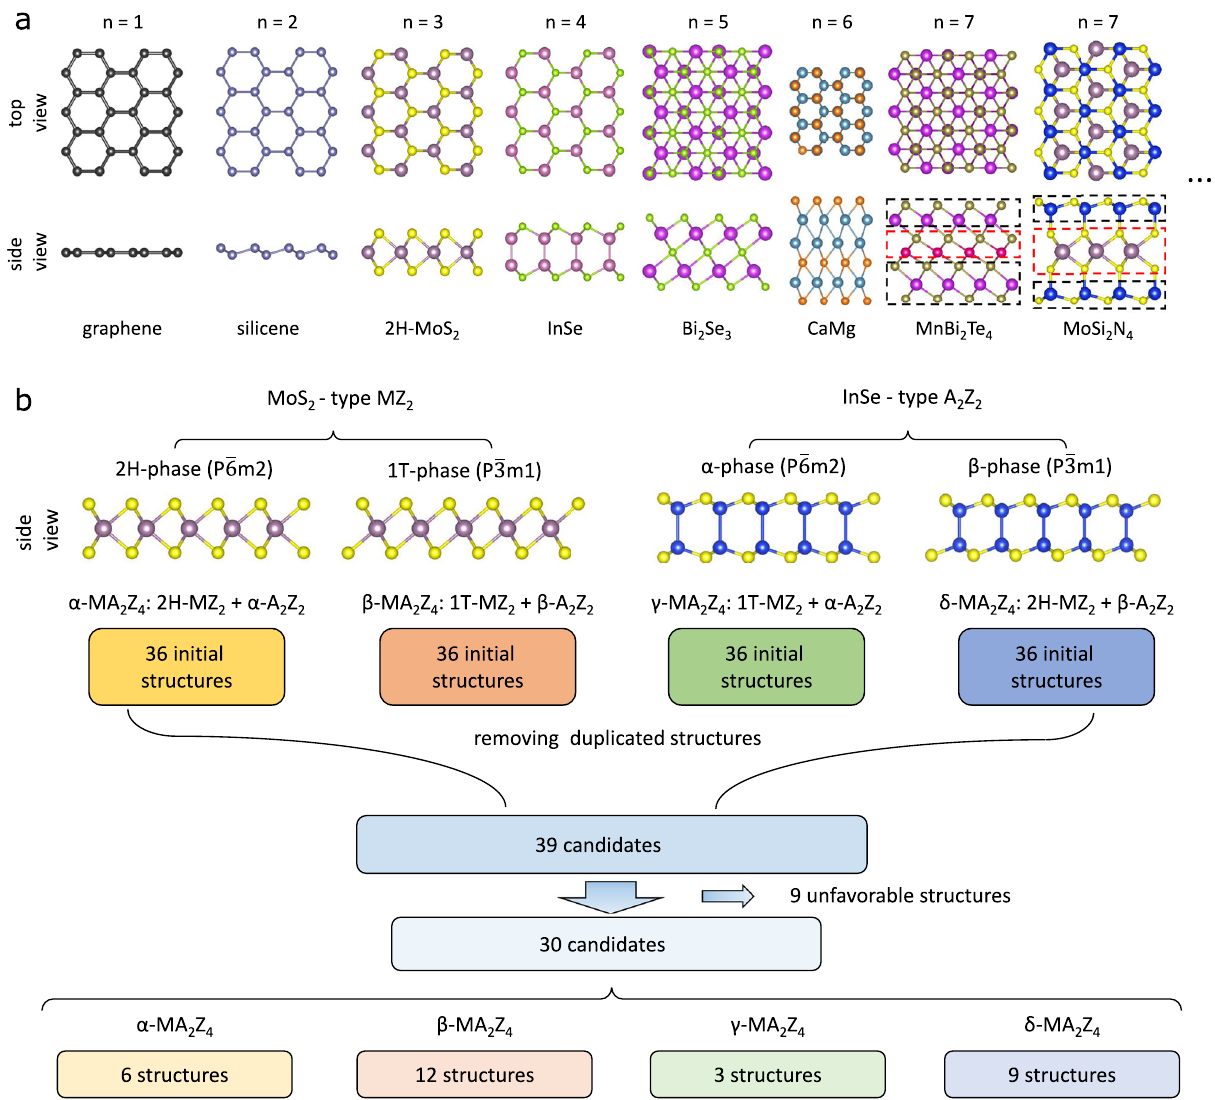
Fig. 1 Geometric structures of known monolayer 2D materials and new MA 2 Z 4 monolayer materials. a Top and side views of representative monolayers for n ≤ 7, all belonging to the SMR materials 17 . b Schematic illustration of the intercalation method that uses the structures of a MoS 2 -like monolayer (2 H - and 1 T phases) and those of an InSe-like monolayer ( α and β phases) to construct the structures of a MA 2 Z 4